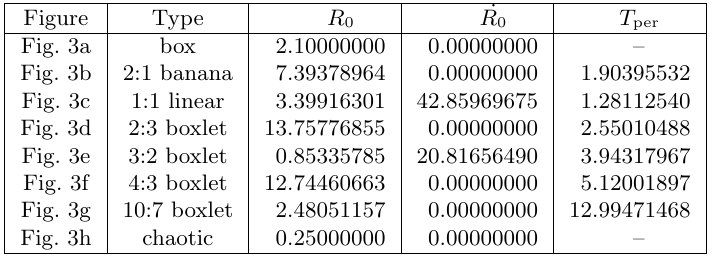
Table 1. Types and initial conditions of the orbits shown in Fig. 3 (a-h). In all cases, z 0 = 0, ˙ z 0 is found from the energy integral, Eq. (8), while T per is the period of the resonant parent periodic